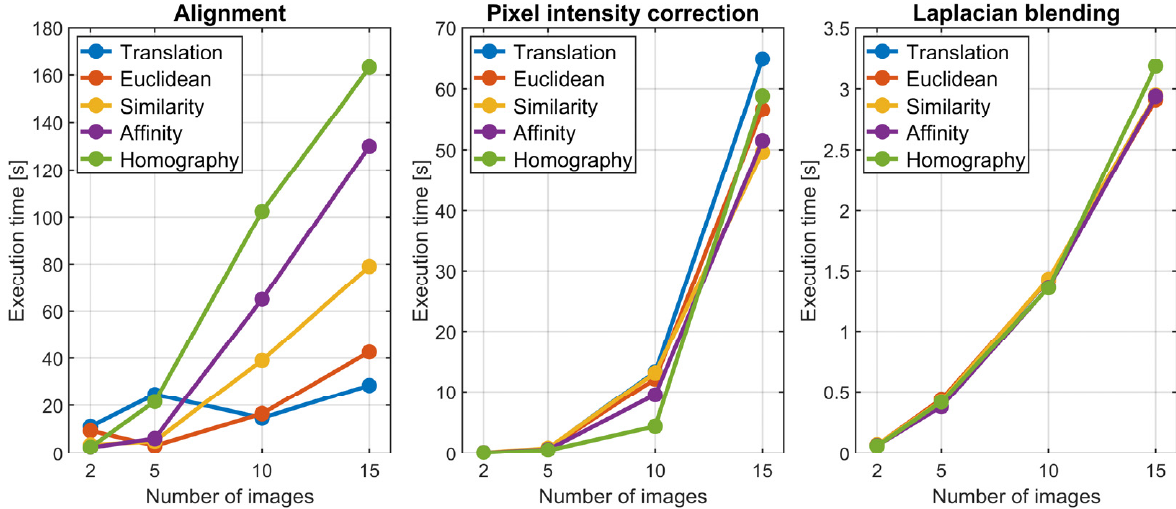
Figure 14. Execution times for alignment, pixel intensity correction and Laplacian blending.